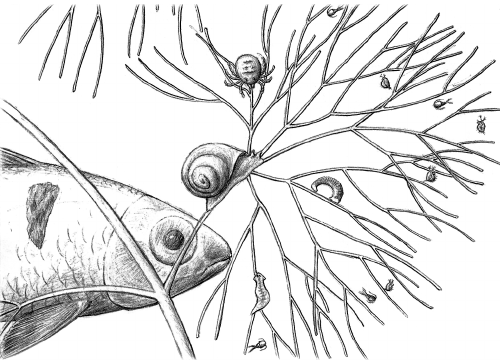
Figure 3. The “like fractal” characteristic of several macrophytes explains why there are more individuals (and species) of smaller organisms. There are more small spaces that can account for a higher number of smaller